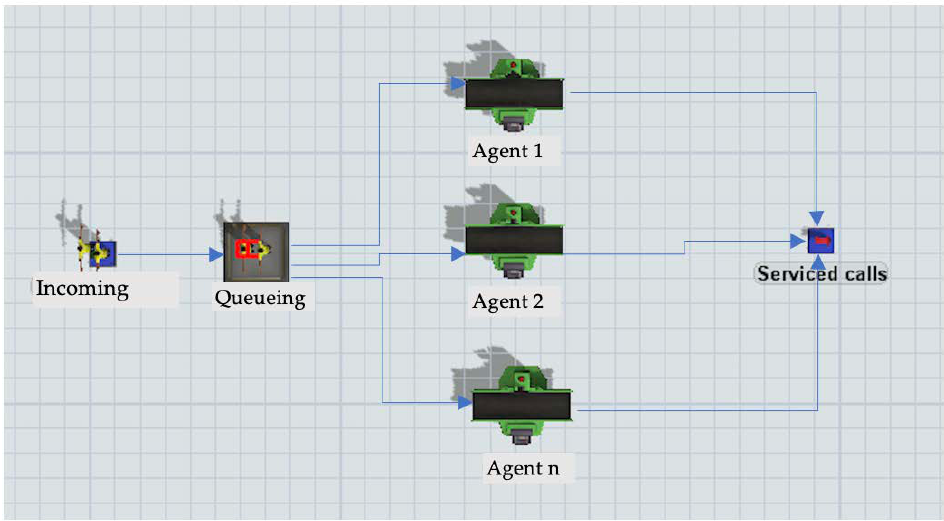
Figure 8. Simulation layout for the number of agents.